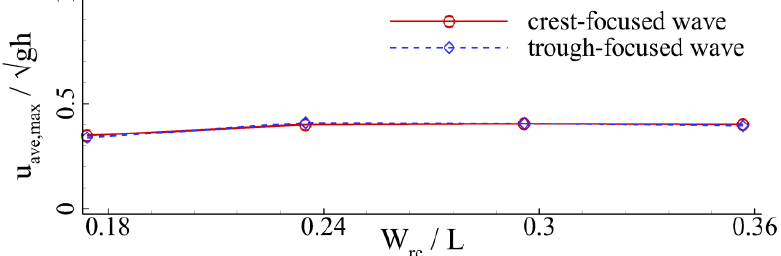
Figure 59. Maximum depth-averaged velocity at the reef crest versus the ridge width.